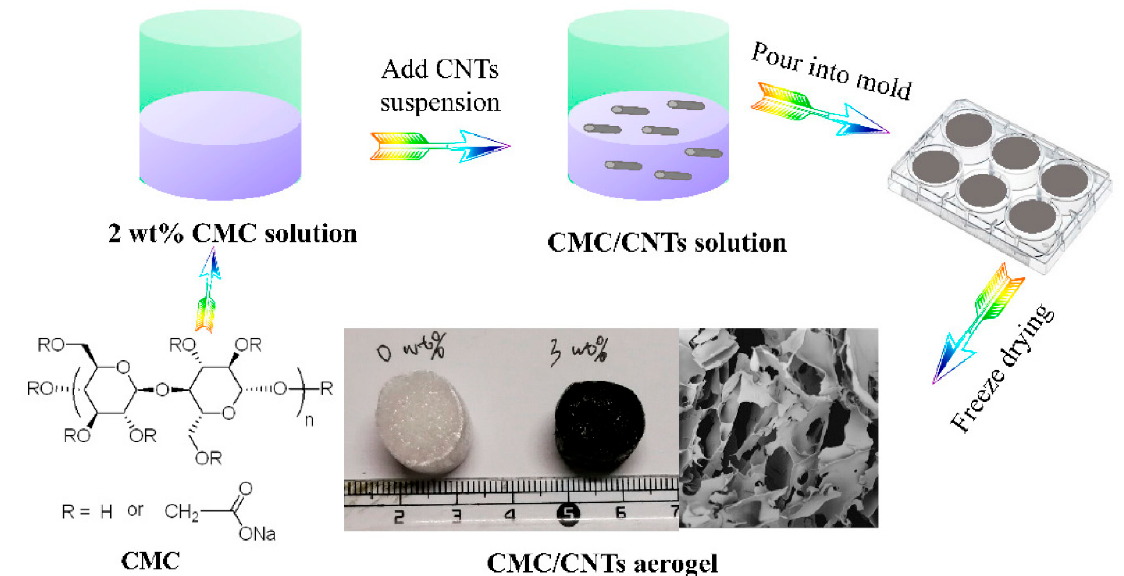
Figure 4. Preparation of CMC / CNTs aerogel. Reproduced with permission from [84]. Copyright MDPI, 2019.